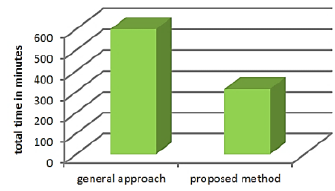
Figure 11. The total time consumption comparison. The RMSE was computed as shown in Table 3 which shows an error of ≅ 3mm before filtering and ≅ 5mm after filtering. To evaluate the accuracy of the created model before filtering, the C2C distance point based comparison is applied using cloud compare software as shown in Fig. 12 and Table 4. The blue colour refers to near zero shift distances while the red colour refers to larger shift distance.